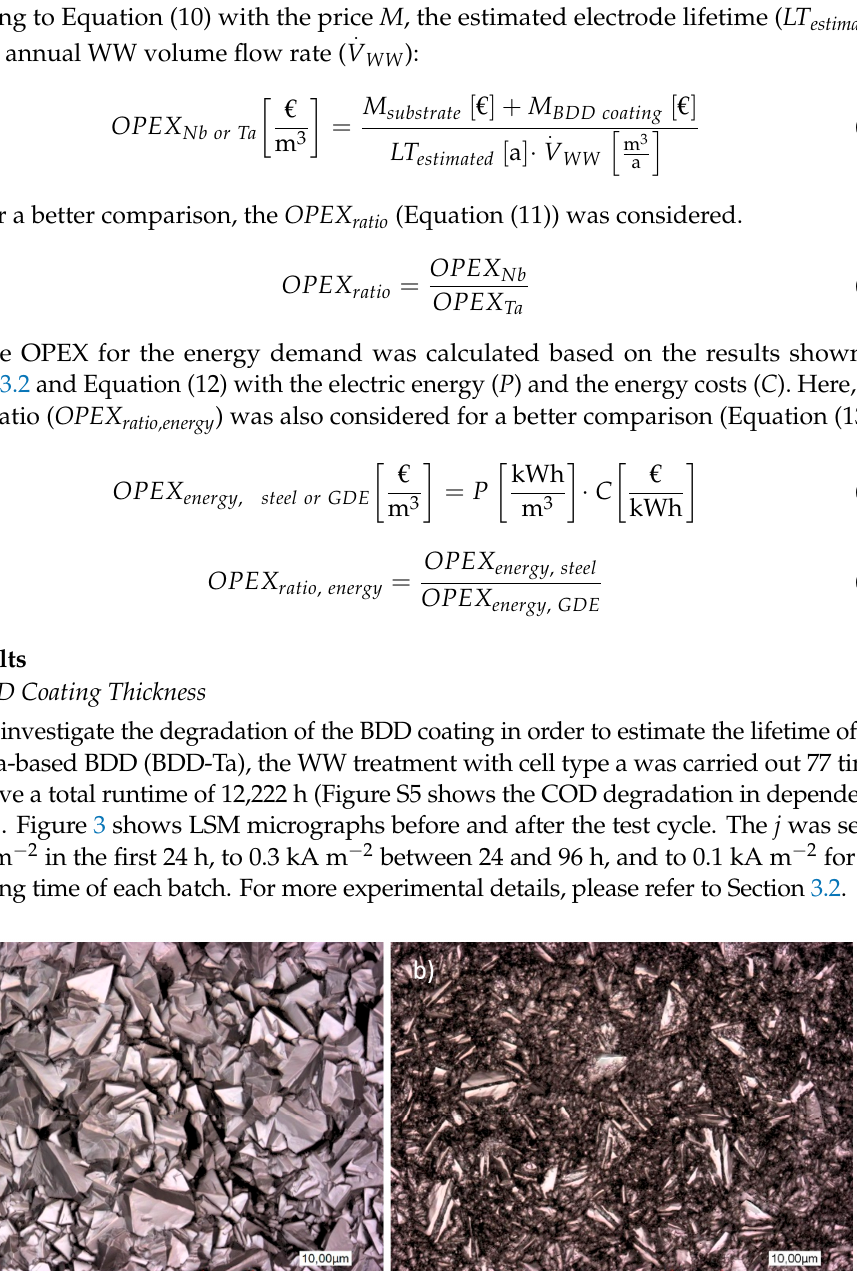
Figure 4. It is obvious that the treatment conditions reduced the coating thickness by 4.8% during the